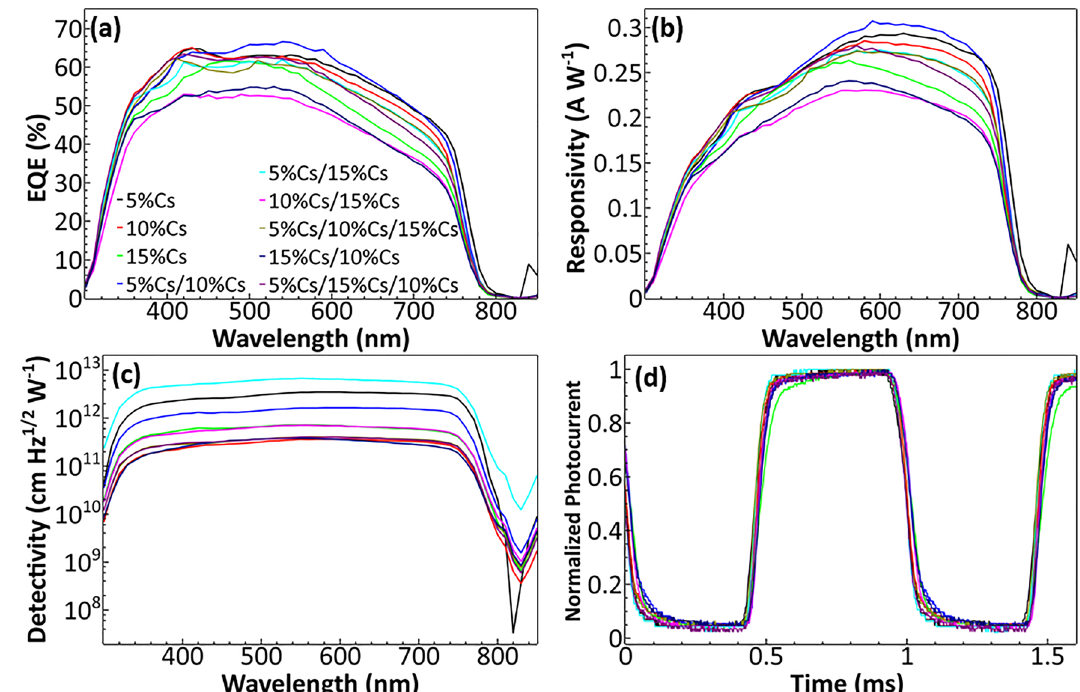
Figure 3. ( a ) EQE, ( b ) Responsivity, and ( c ) Detectivity spectra of single, double, and triple-layer perovskite PPDs. ( d ) Normalized photoresponse of PPDs under 1000 Hz optical